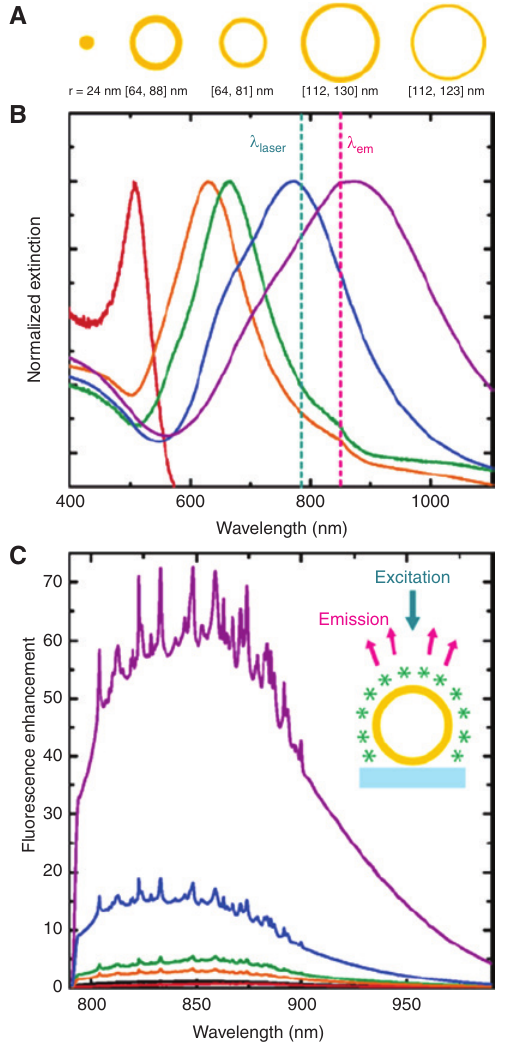
Figure 12: Schematics of the relation between Raman intensity and diameter of gold